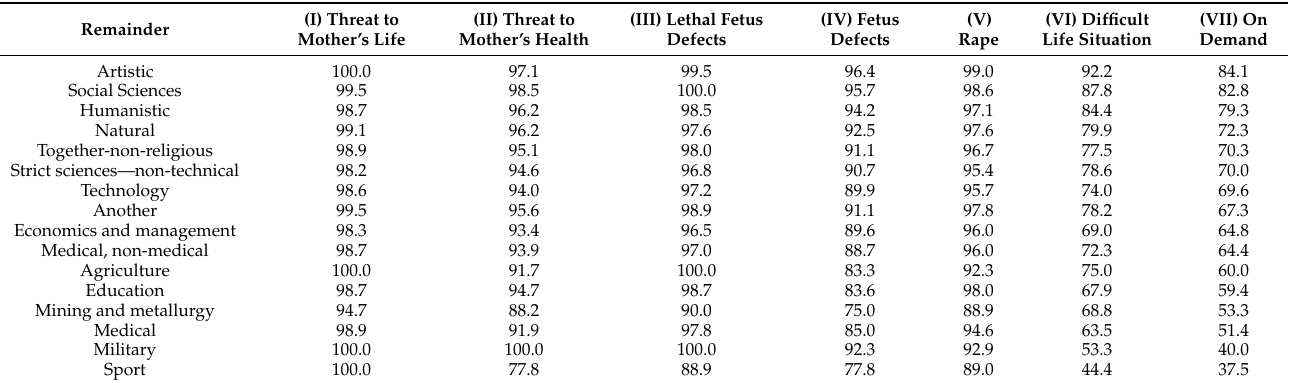
Table 8. Attitude to abortion among remainder students regarding field of study. All data contained in table are presented as percentage [%] of answers YES for question “Do you think abortion should be legal in the following cases?” in each case.